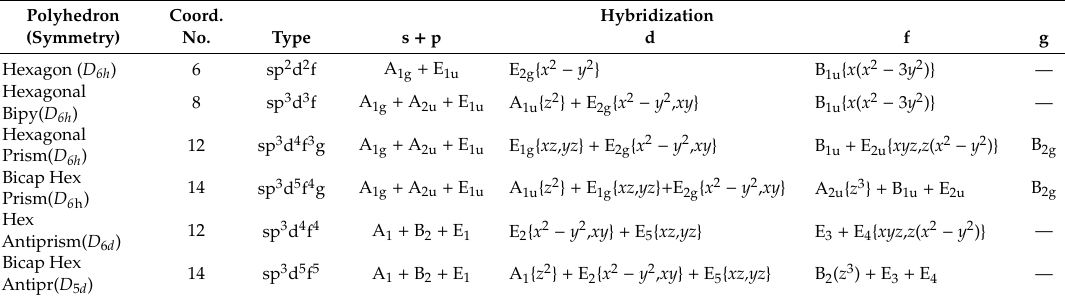
Table 5. Hybridization schemes for the hexagonal polyhedra.